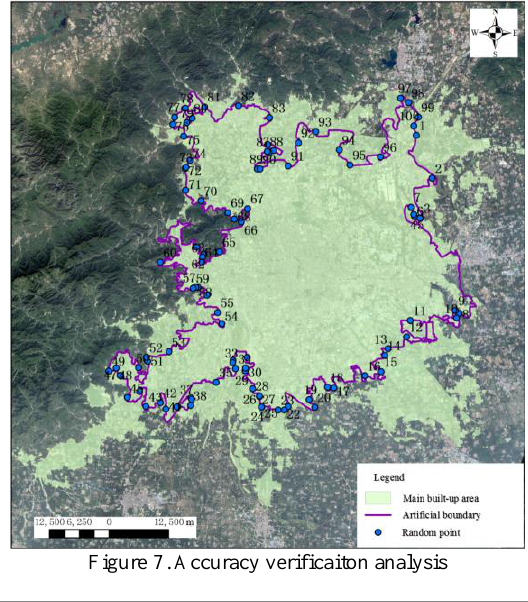
Figure 7. Accuracy verificaiton analysis